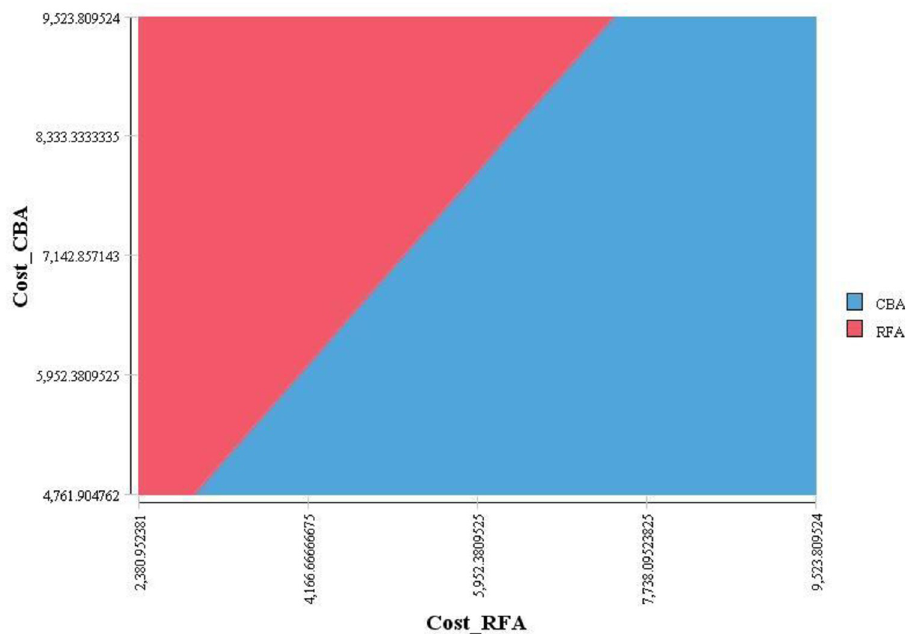
Fig 5. Two way sensitivity analysis (RFA cost and CBA cost).